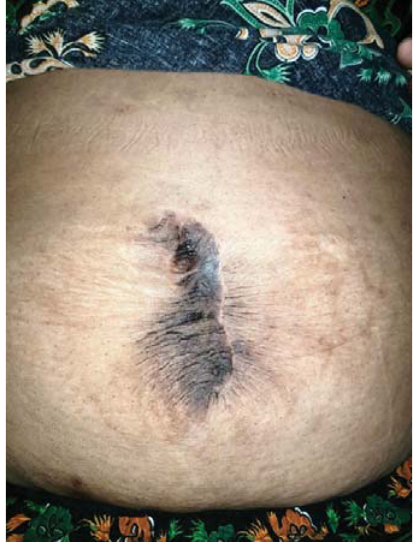
Figure 4. Wound at four month follow